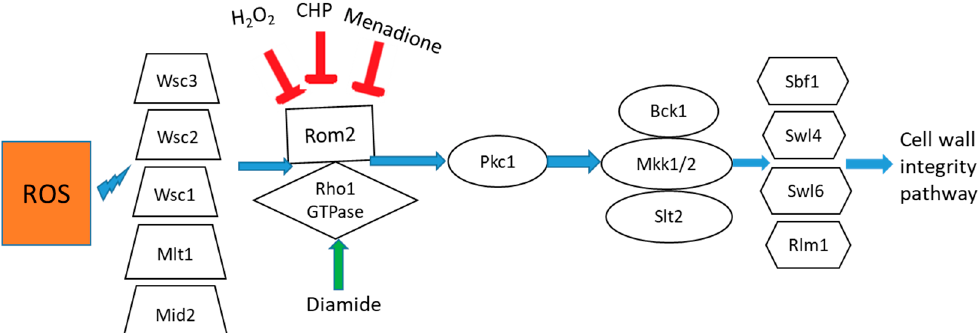
Figure 4. Model for how different oxidants affect the Rho protein signal transduction in S. cerevisiae at 3 min. Menadione, CHP and H 2 O 2 -induced oxidative stress disrupt the signal transduction, causing defective cell wall homeostasis. Symbols: protein kinases, ovals; guanosine triphosphate (GTP)-binding proteins, diamonds; scaffold, adaptor, and activating proteins, rectangles; cell surface proteins, trapezoids; transcription factors, hexagon; activation, arrows; inhibition, T-bars.